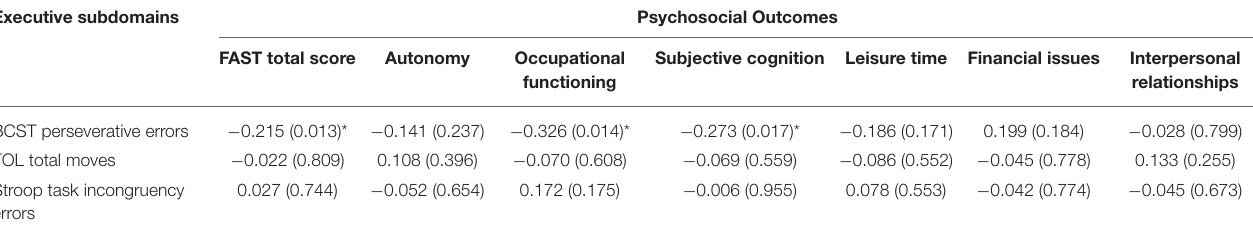
TABLE 3 | Domain specific relationships between executive subdomains and FAST outcomes in the remitted depression group ( N = 52), expressed by standardized Beta